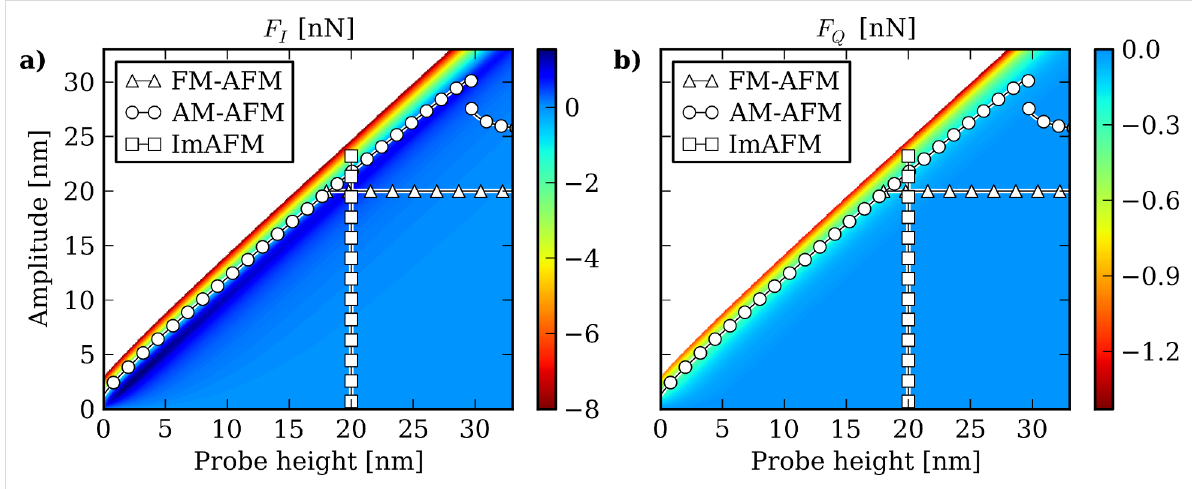
Figure 6: Model F I ( h , A ) and F Q ( h , A ) maps for the vdW-DMT force with exponential damping introduced in Equation 40. The displayed measurement paths correspond to a frequency-shift–distance curve in FM-AFM, an amplitude–phase–distance curve in AM-AFM and an ImAFM measurement. In contrast to FM-AFM and AM-AFM, the static probe height is constant during an ImAFM measurement and the h – A plane is explored along a path parallel to the A axis. One should also note the amplitude jump along the AM-AFM path at a probe height of h = 30 nm.